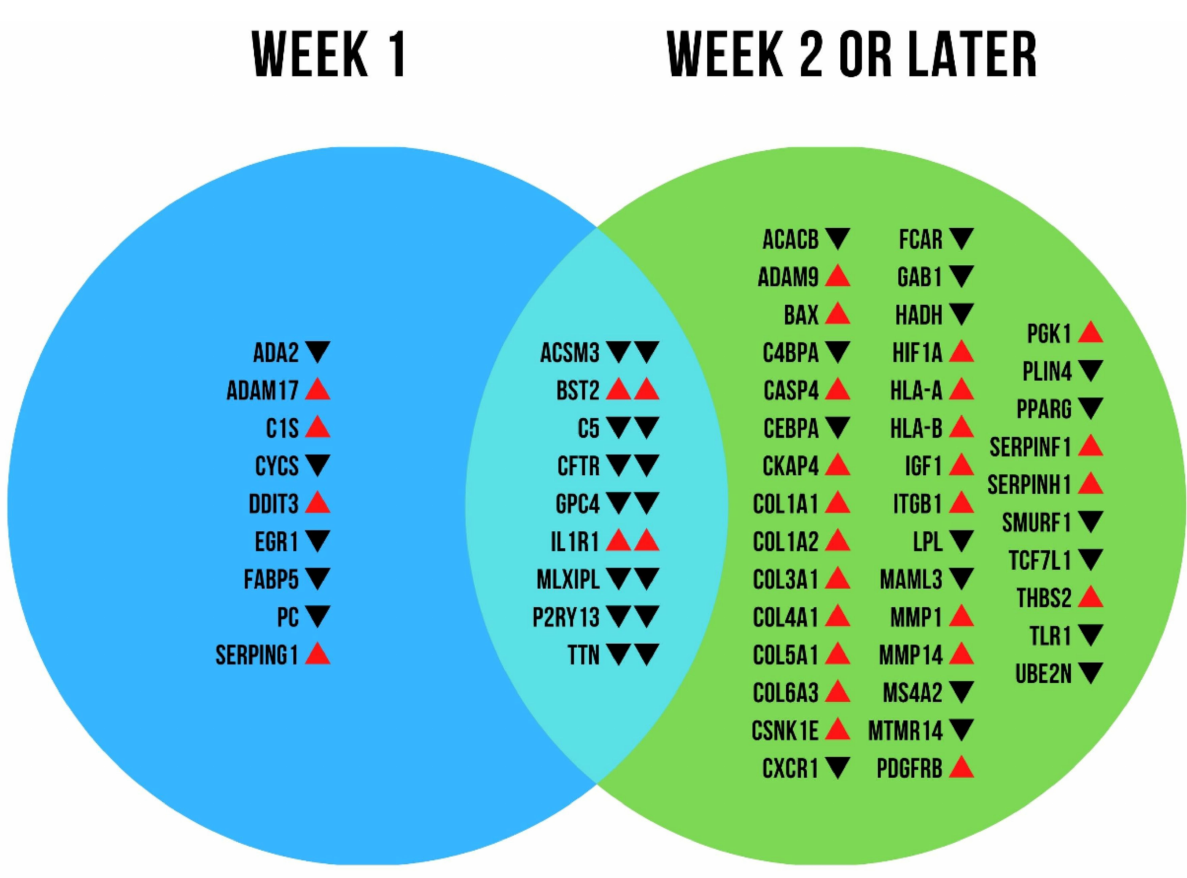
Figure 1. mRNA expression analysis. Venn diagram of differentially regulated genes over time. Arrows indicate increased (red arrow up) or decreased (black arrow down) activity of the respective genes in the group of patients who succumbed to COVID-19 within the first week of hospitalization (“week 1”) or later (“week 2 or later”) compared to healthy control lungs, respectively. In the overlapping area (middle), the left and right arrows indicate the expression in week 1 and week 2 or later,